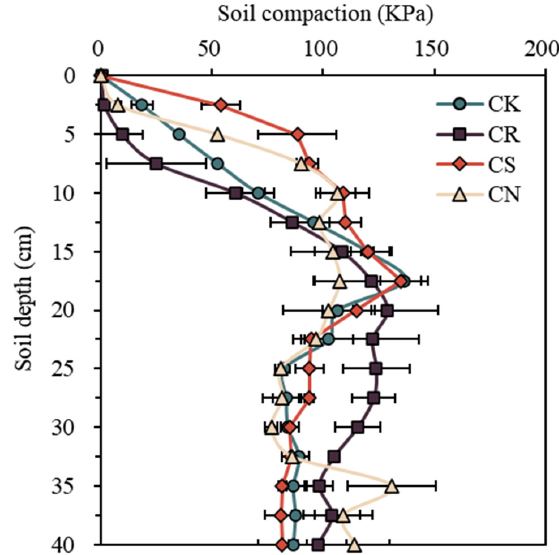
Figure 4. Soil compaction at the 0–40 cm depth as affected by tillage regimes in 2021. CK, rotary tillage without straw returning; CR, rotary tillage with straw incorporation; CS, subsoiling tillage with straw mulching; CN, no tillage with straw mulching. Bar means the standard error.